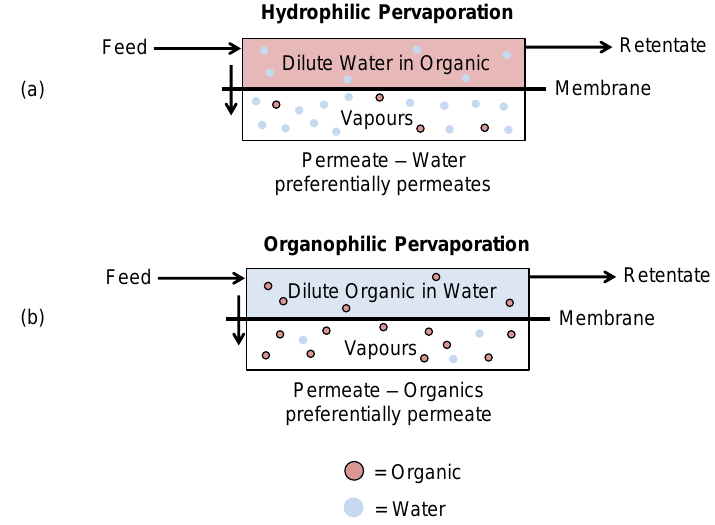
Figure 12. Schematic of ( a ) hydrophilic and ( b ) organophilic pervaporation processes.